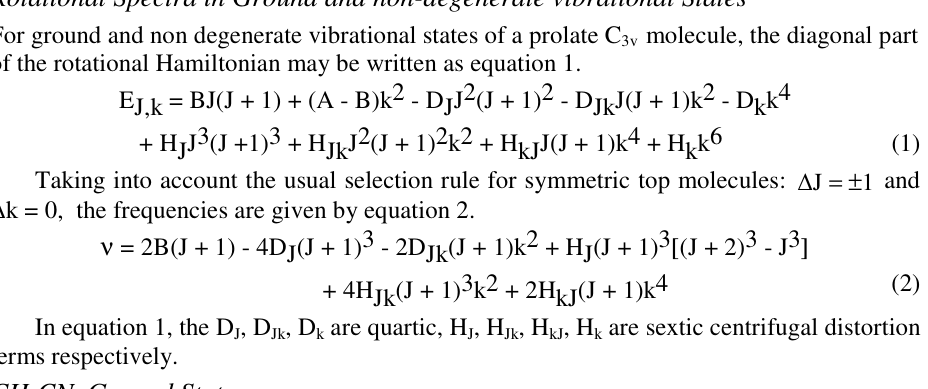
CN in the ground state 18-20 . 3